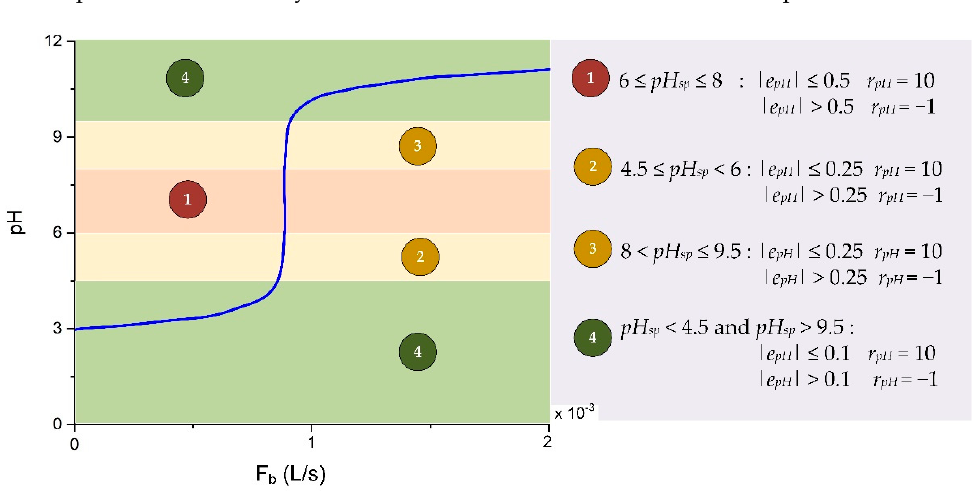
Figure 8. Criteria curve of the pH control system.